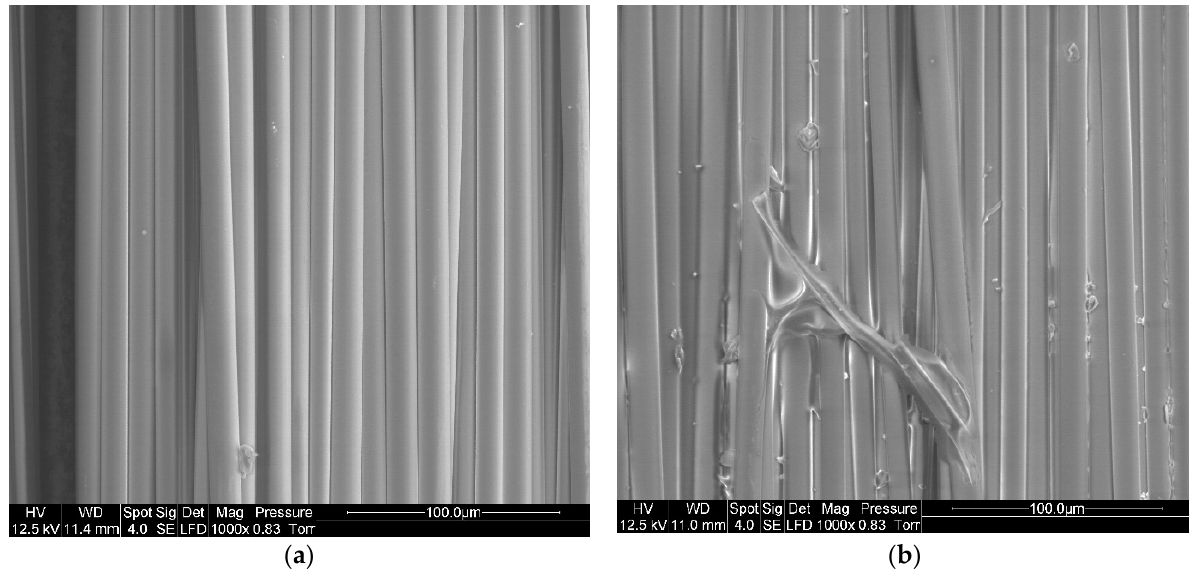
Figure 9. SEM image of ( a ) Virgin basalt fibers, ( b ) Recycled basalt fibers dissolved in acetone for 24 h at a solvent ratio of 1:4.